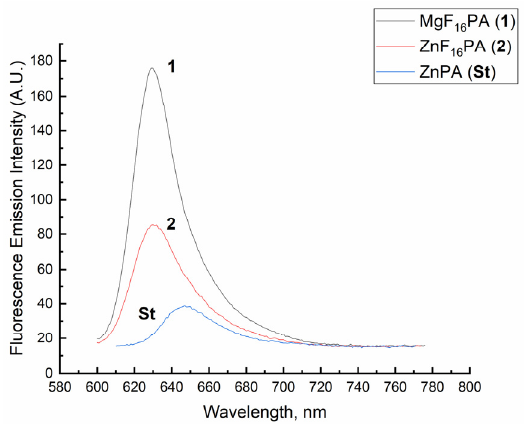
Figure 3. Fluorescence spectra of compounds 1 and 2 and the standard (ZnPA). The spectra were normalized by division by the fluorescence intensity maximum. The quantum yield of fluorescence was calculated by the formula [21].